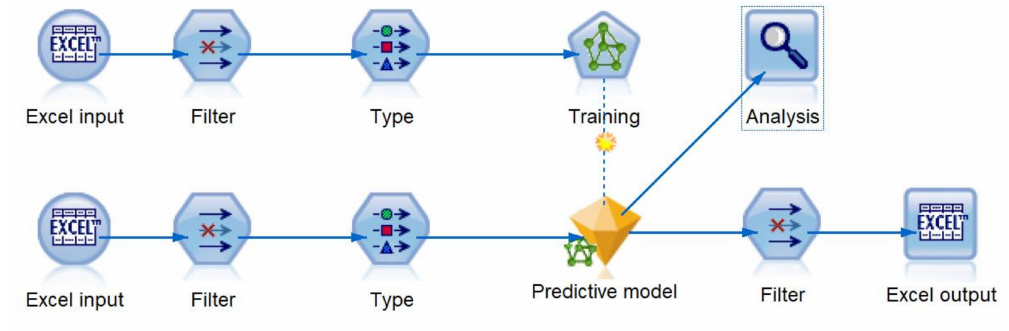
Figure 9. Scoring stream built in IBM SPPSS